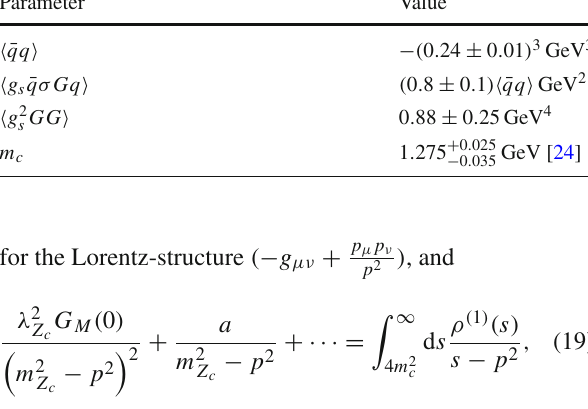
Table 1 Some input parameters needed in the calculations Parameter